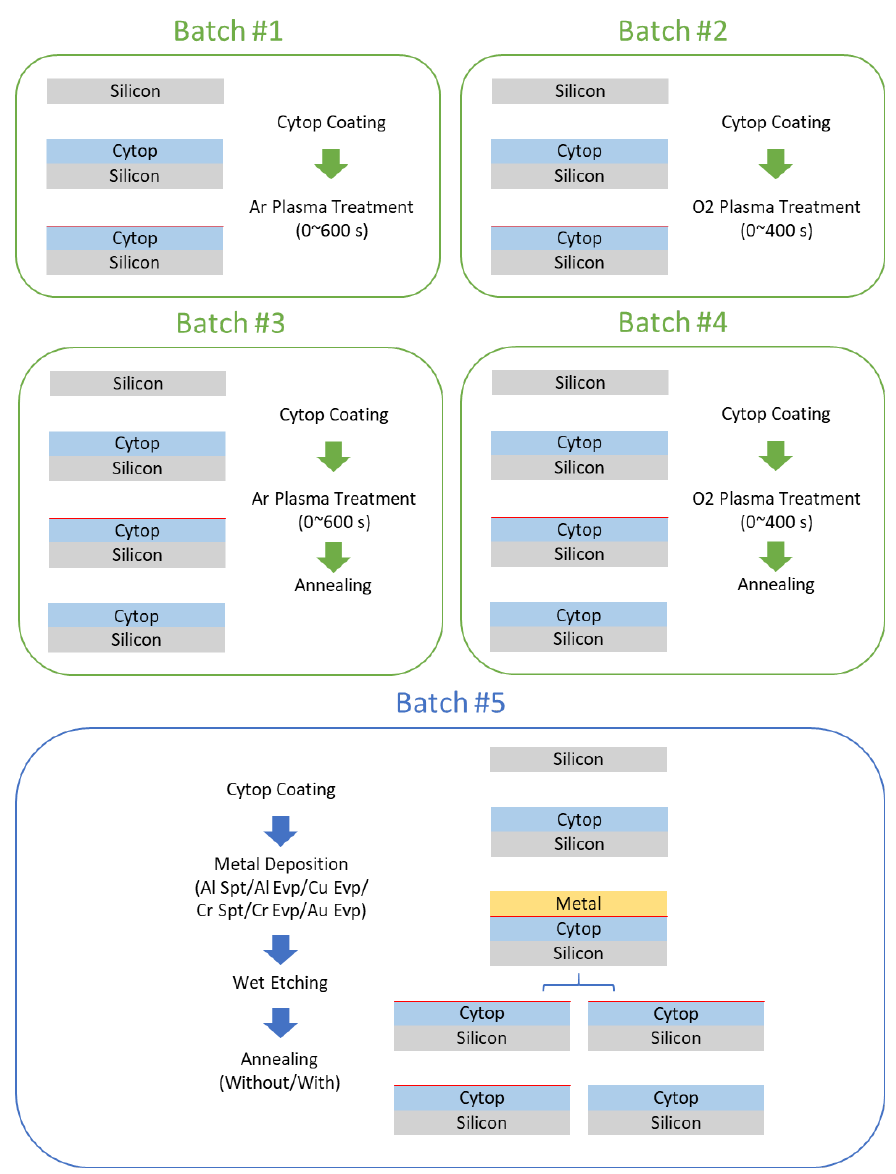
Figure 2. Experiment design.